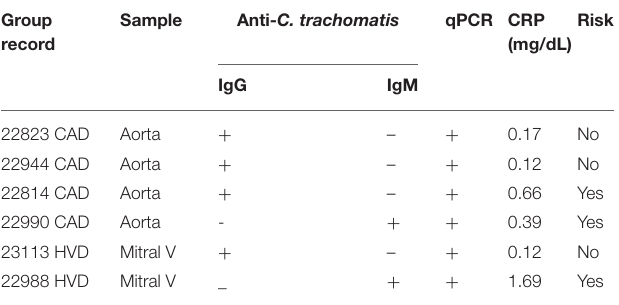
TABLE 3 | Serology results for C. trachomatis according to the patient group, the origin of the tissues investigated for the presence of the cryptic plasmid and CRP